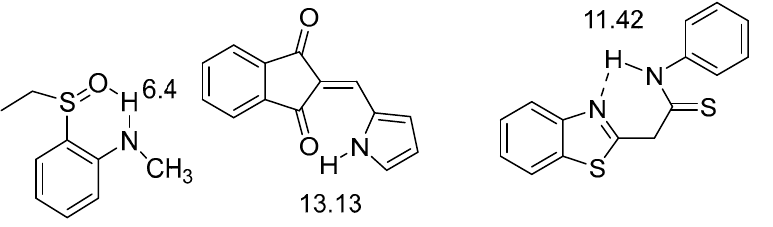
Figure 9. Hydrogen bonding with different motifs. The numbers are NH chemical shifts in ppm.